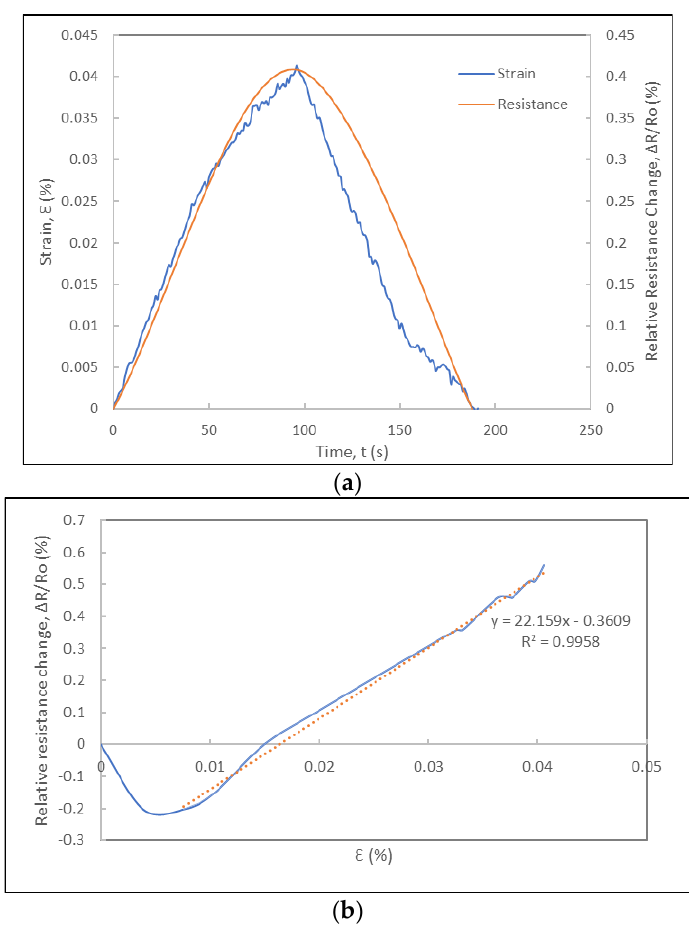
Figure 10. Electromechanical response of foil strain gauge prototype under cyclic loading at displacement rate of 150 µ m/min: ( a ) Strain and relative resistance change histories during one cycle; ( b ) Relative resistance change versus strain curve of loading cycle and corresponding gauge factor.